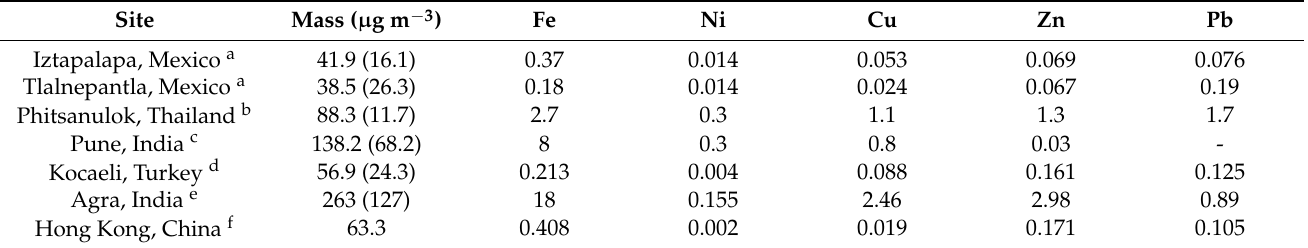
Table 3. Comparison of PM 10 elemental concentrations ( µ g m − 3 ) determined in households from different urban areas.